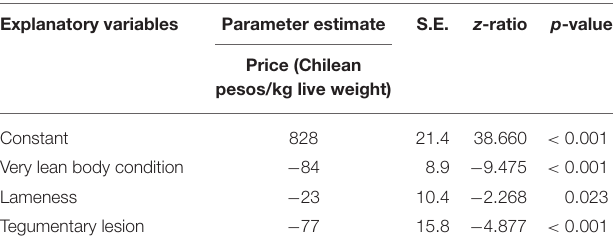
TABLE 6 | Parameter estimate, standard error (S.E.), and significance for the models of health and price per kg live weight during auction of cows in the